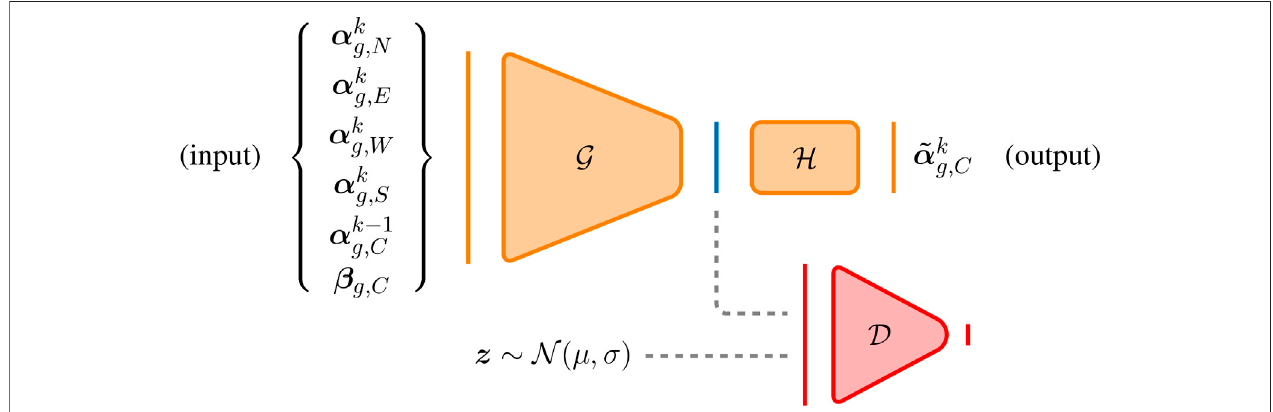
FIGURE2| Thepredictiveadversarialnetwork.Thegeneratorisrepresentedby G ;thebluelinerepresentstheadversariallayer(andistheoutputof G );thenetwork H maps the values in the adversarial layer to the output; the input to the discriminator D is either a (genuine) sample from the prior distribution (here N ( μ , σ ) ) or a (fake) sample from the output of the generator.